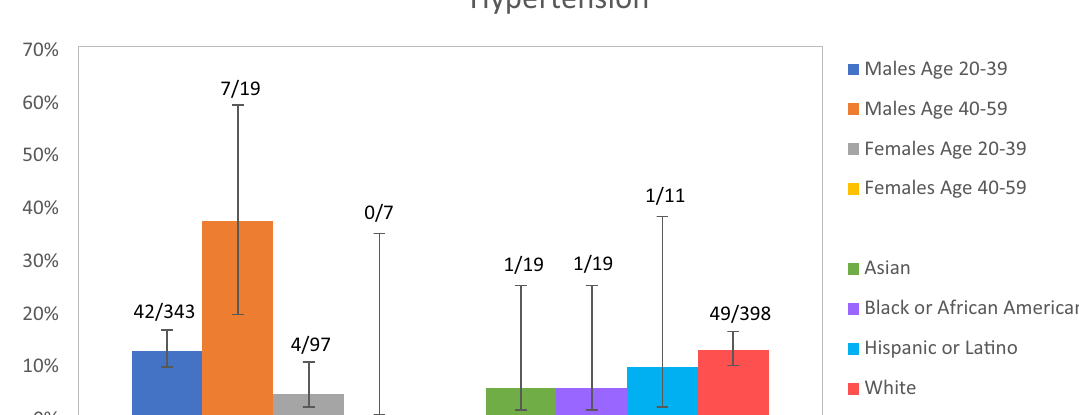
Figure 3. Sample prevalence of hypertension in ASD patients by sex, age category (years), and race and ethnicity. Error bars correspond to the width of 95% confidence intervals for prevalence estimates. Observed frequencies are reported above error bars. Data on hypertension were missing for 11 males age 20–39 years, 1 male age 40–59 years, and 4 females age 20–39 years. Estimates are not reported for age 60 years and over because only one participant was over age 60 years. Race and ethnicity categories were taken from the patient data registry. Race and ethnicity category was missing for 17 adults with hypertension data.